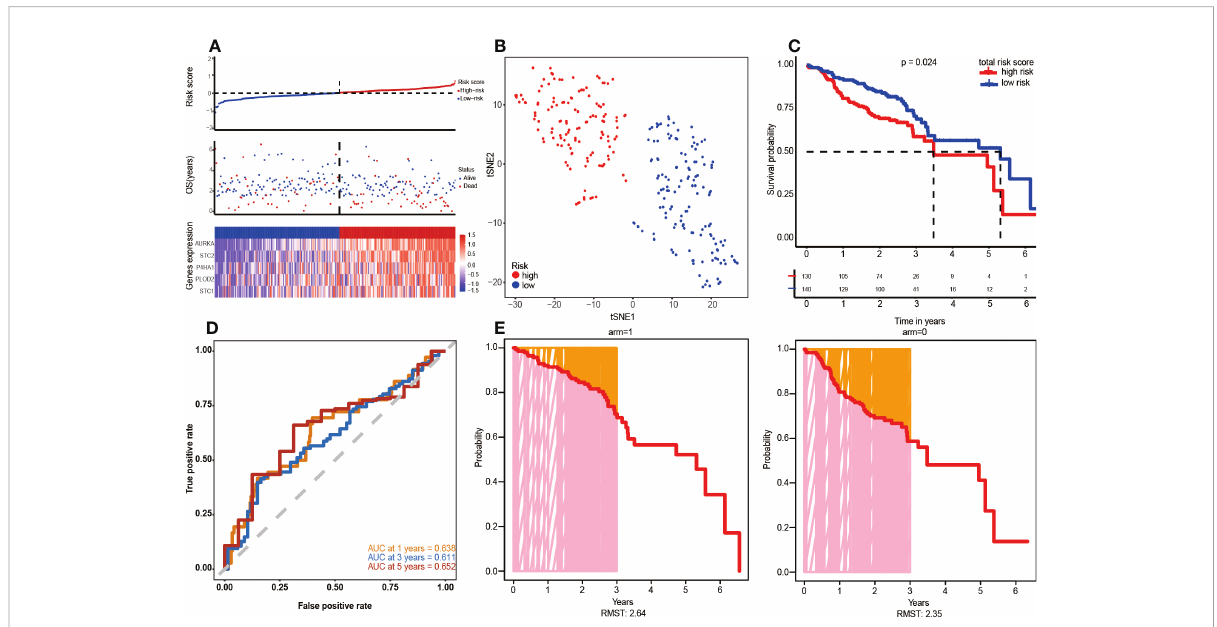
FIGURE 4 Veri fi cation of the fi ve-gene signature in the validation cohort (GSE65858). (A) Risk map of patients based on risk score heatmap of survival status and risk gene expression pro fi les of individual HNSCC patients. (B) t-SNE grouping cluster. (C) Kaplan – Meier curves according to the fi ve- gene signature. Log-rank tests were performed to determine the p values. (D) ROC curve and AUC values of fi ve-gene feature classi fi cation in GEO. (E) RMST plot for the GEO testing set.